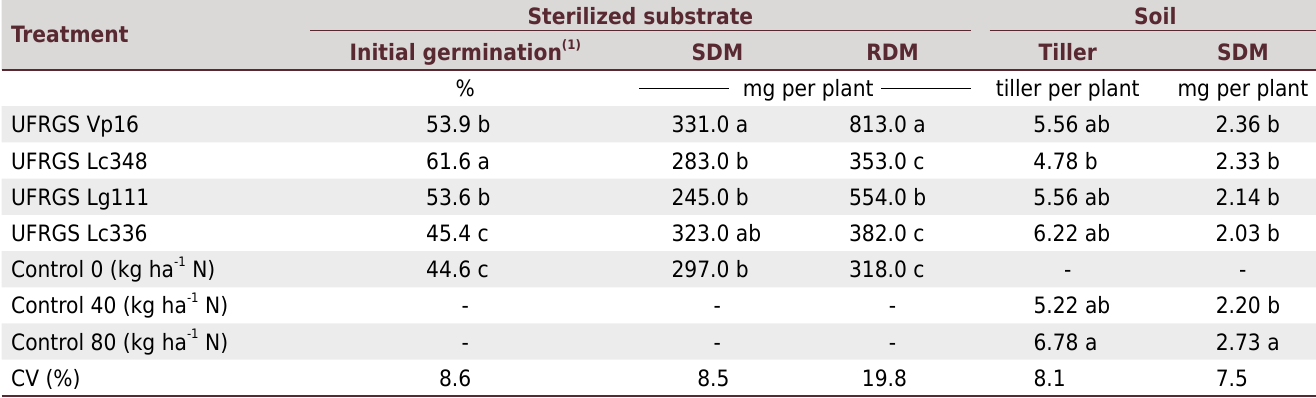
Table 2. Initial germination, shoot (SDM) and root dry matter (RDM), and tillering of IRGA 422CL rice cultivar plants inoculated with isolates of rhizobia native to southern Brazil grown in pots with sterilized substrate and soil